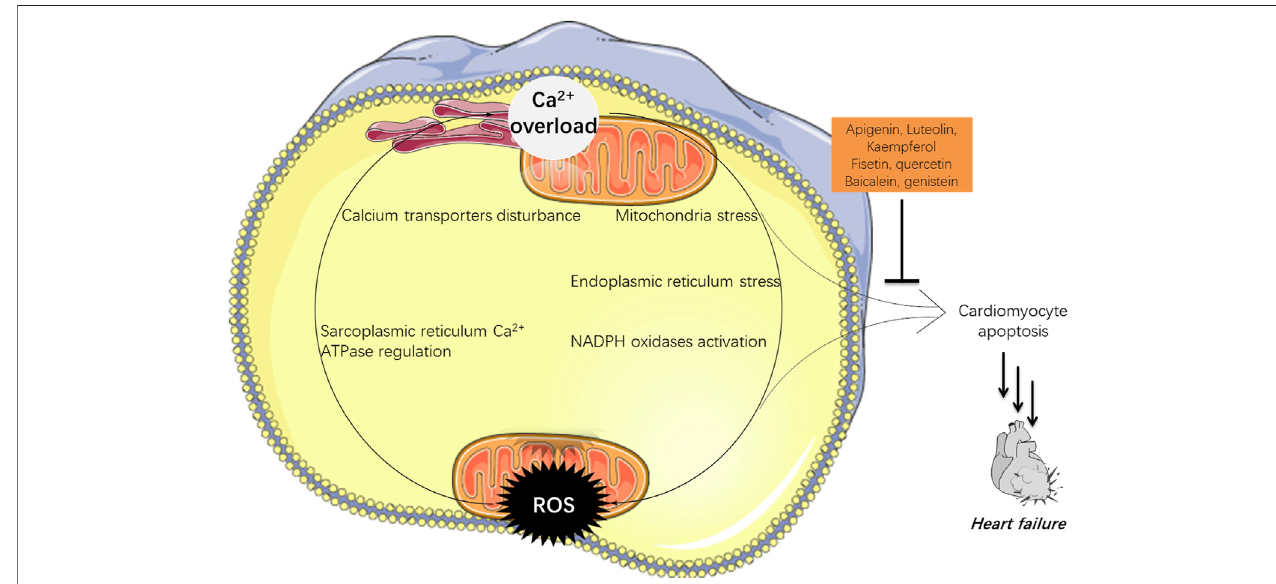
FIGURE 1 | The interactions between calcium and ROS in HF. Over-loaded calcium could not only induce apoptosis, but also stimulate the production of ROS which may initiate cell death. Flavones hold potential in navigating both of them which can be adopted in HF treatment.